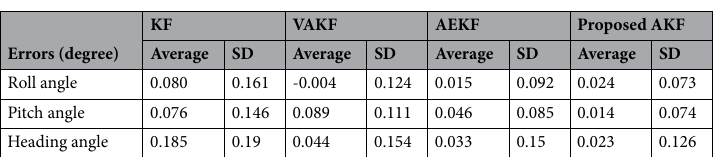
Table 3. Results comparison in the turning